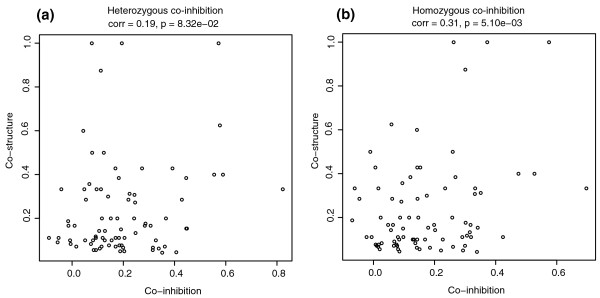
The limited correlation between Tanimoto structural similarity and co-fitness in the heterozygous and homozygous datasets suggests that chemical structure influences inhibition patterns but does not exclusively define them. Each point represents a pair of compounds; to allow for comparison between (a) heterozygous and (b) homozygous datasets, for this figure we used only pairs of compounds that were tested in both datasets.